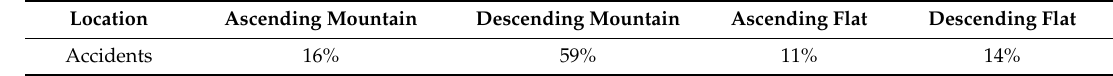
Table 4. Locations of